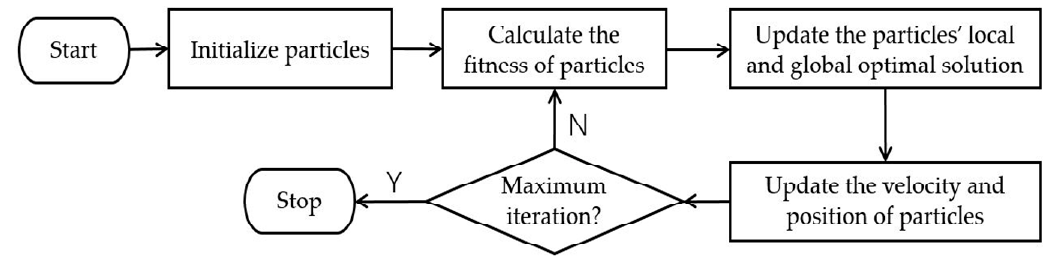
Figure 2. The workflow of PSO.